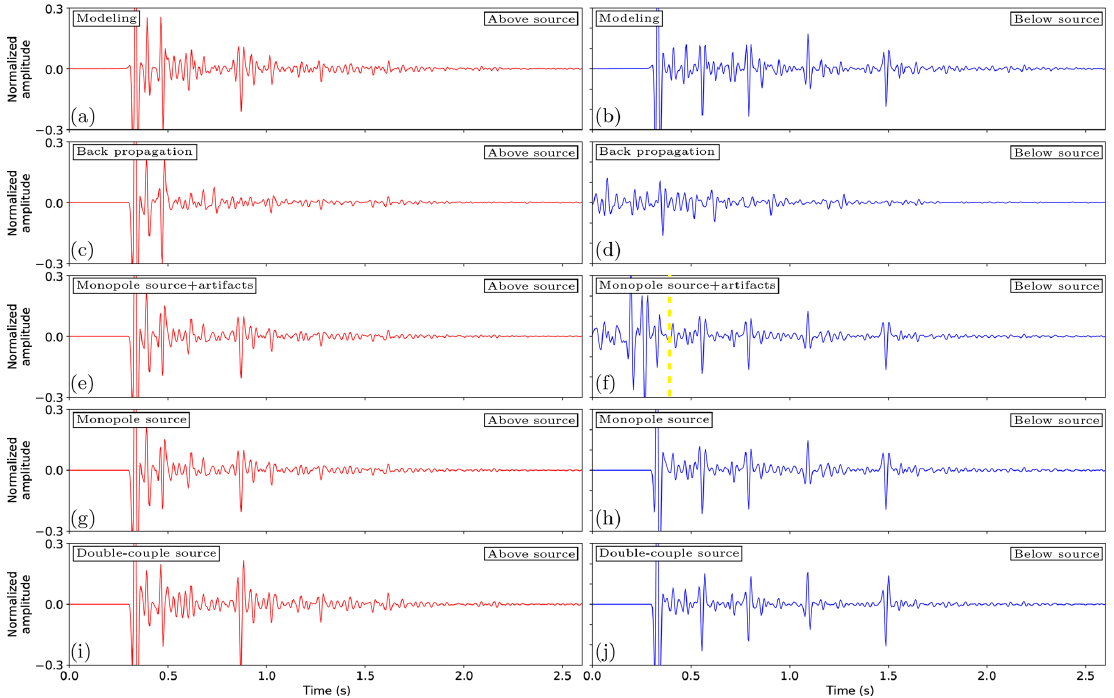
Figure 7. Traces from receivers in the subsurface at two locations, extracted from Fig. 6. In the left column, the receiver is located above the source and corresponds to the red dot in Fig. 6a, and in the right column it is located below the source and corresponds to the blue dot in Fig. 6a. (a–b) Directly modeled wave field using the exact model from Fig. 5a and b. (c–d) Back-propagated wave field obtained using Eq. (23). (e–f) Wave field in the subsurface, retrieved for virtual receivers and a virtual source using Eq. (15). The yellow line in (f) indicates the time after which the correct signal is retrieved. (g–h) Similar to (e–f) for the homogeneous wave field using Eq. (16). (i–j) Similar to (g–h) using Eq. (19) and a double-couple signature inclined at an angle of 45 ◦ . All wave fields have been convolved with a 30Hz Ricker wavelet.